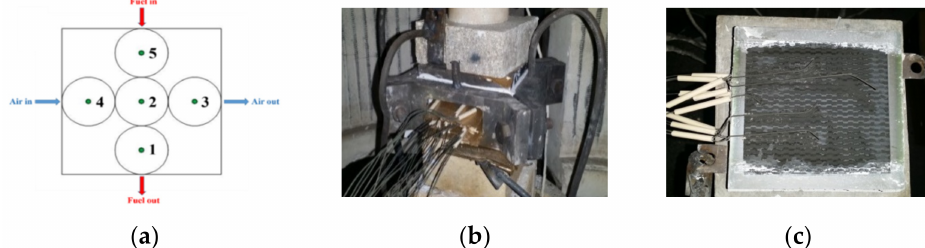
Figure 3. Structure of SOFC stack: ( a ) Stack cross-flow structure; ( b ) SOFC stack; ( c ) SOFC single